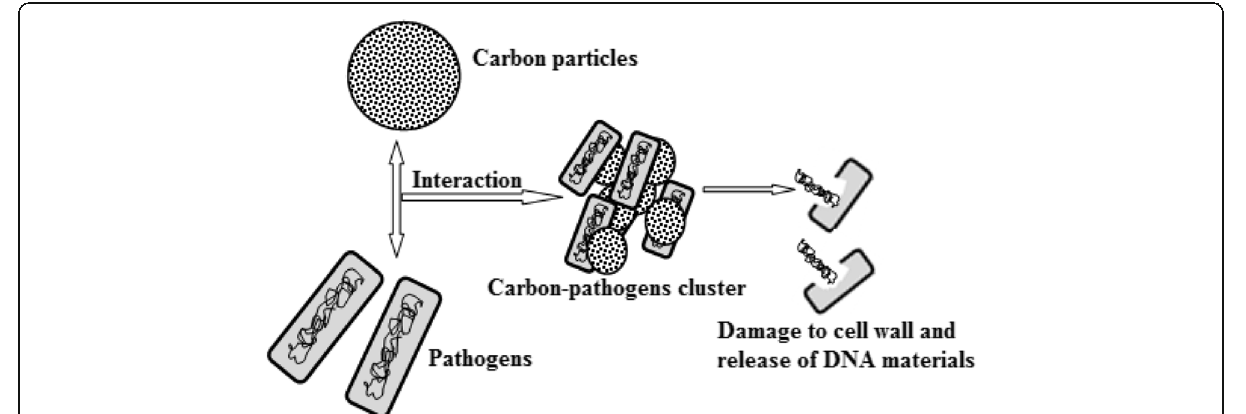
Fig. 9 Representation of probable mechanism of antimicrobial activity of